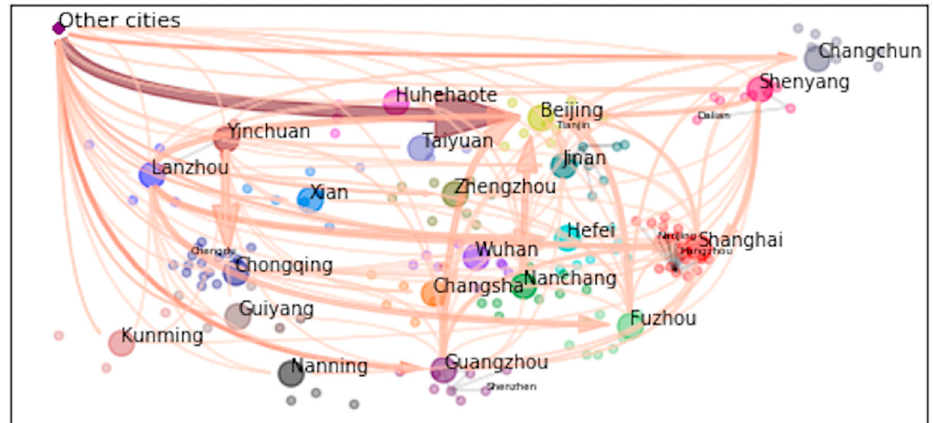
Figure 1. Migration flow network. The data is officially acquired from a database initiated by Minsheng Weekly, a subsidiary of the People’s Daily. The database by Minsheng has a random subsample of the resume database of zhaopin.com. The data is accessible for research purpose, but one has to apply